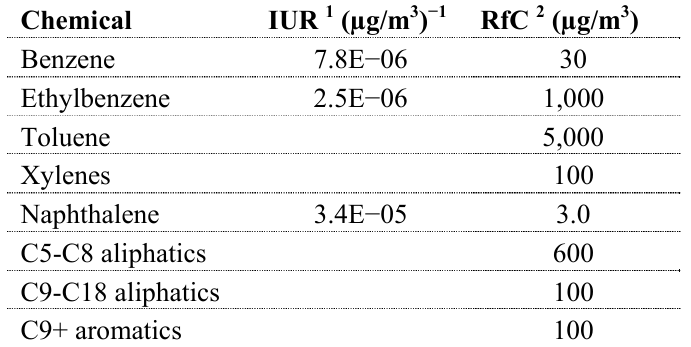
Table 5. Inhalation toxicity factors for targeted VOCs and carbon range